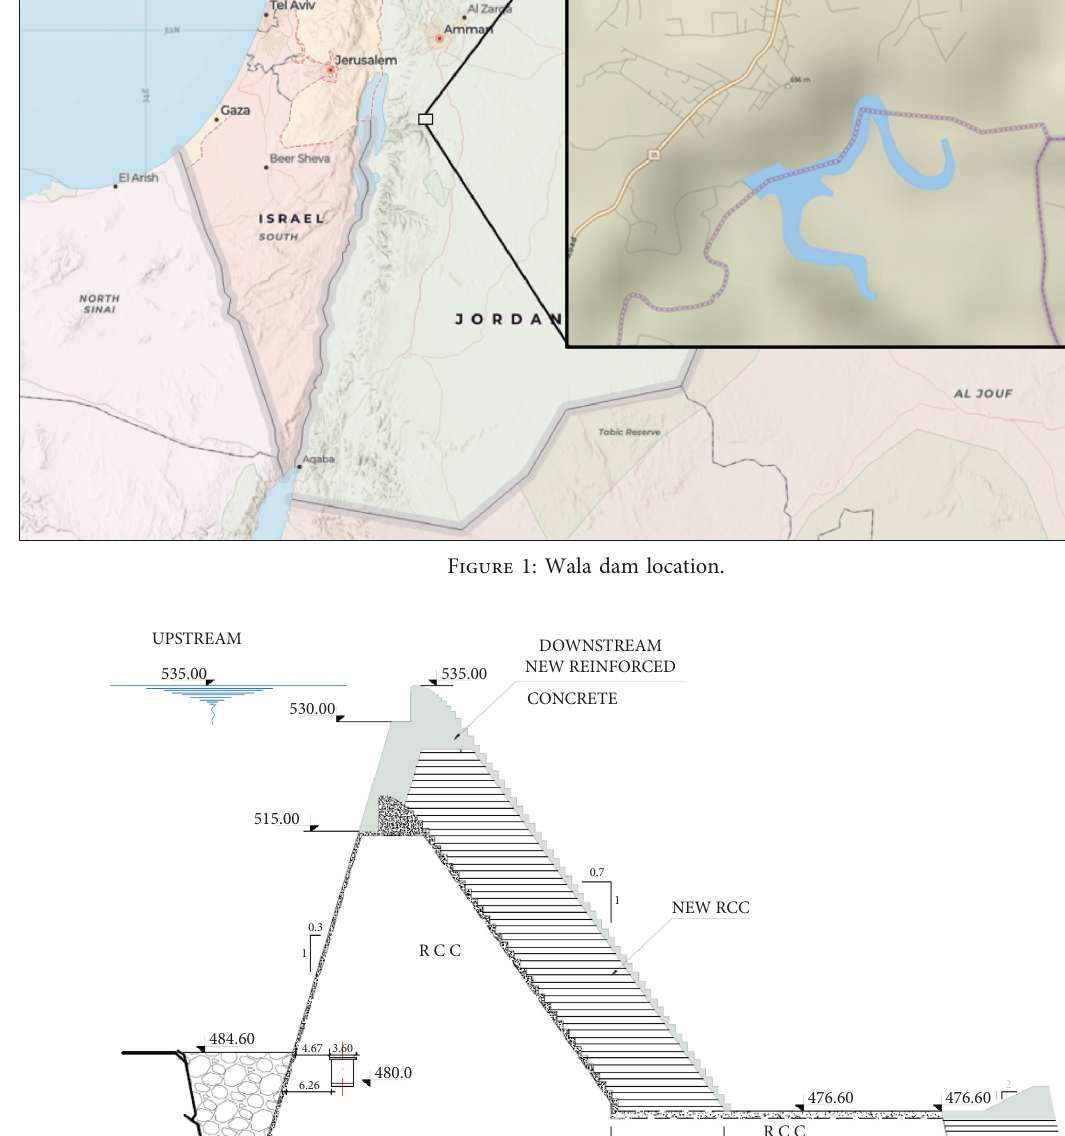
Figure 2: Cross-section of the main body of the Wala dam (original section and new raised section, after JVA,